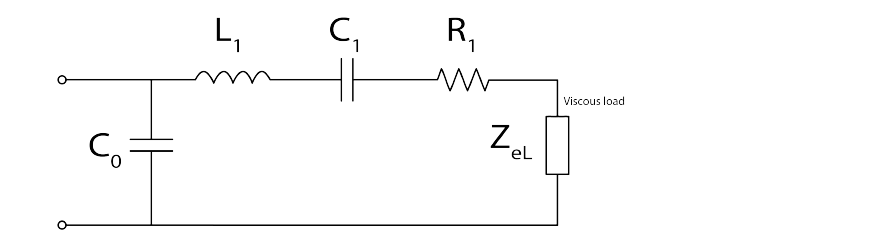
Figure 12. The equivalent circuit of the Quartz Crystal Microbalance (QCM), the Butterworth–Van Dyke model with viscous loading.